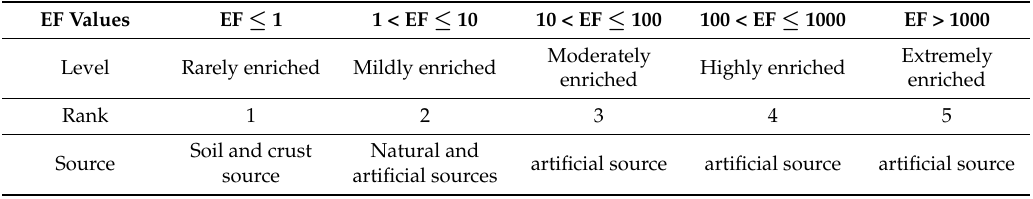
Table 3. Relationships of EF and enrichment degree of the chemical elements in